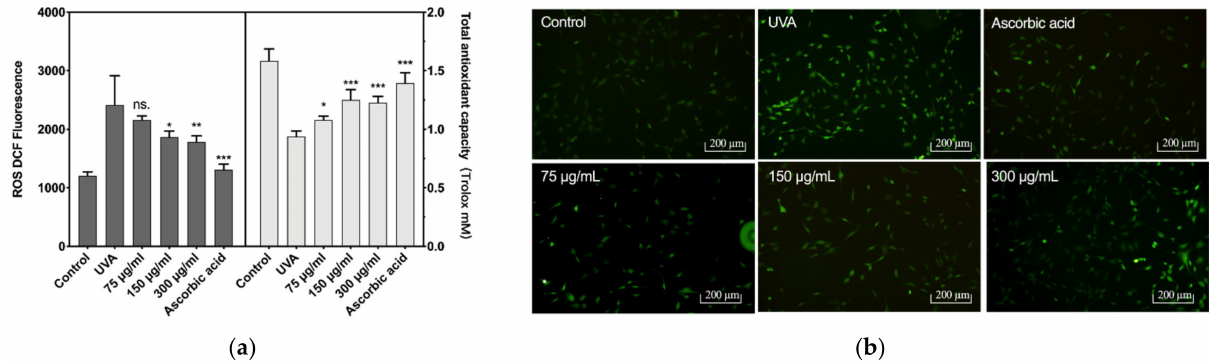
Figure 3. Intracellular reactive oxygen species levels and antioxidant capacity. ( a ) The fluorescence intensity of intracellular ROS (Left) and the total antioxidant capacity of the cell (Right), ( b ) the fluorescence photo of intracellular ROS. Difference analysis between sample group and UVA model group: ns.: p > 0.05, *: p < 0.05, **: p < 0.01, ***: p <